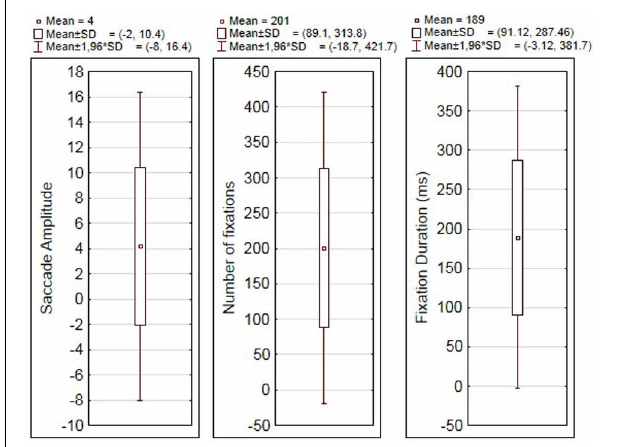
FIGURE 2 | Averages and standard deviations for fixation duration (ms), number of fixations and saccade amplitude (degrees of visual